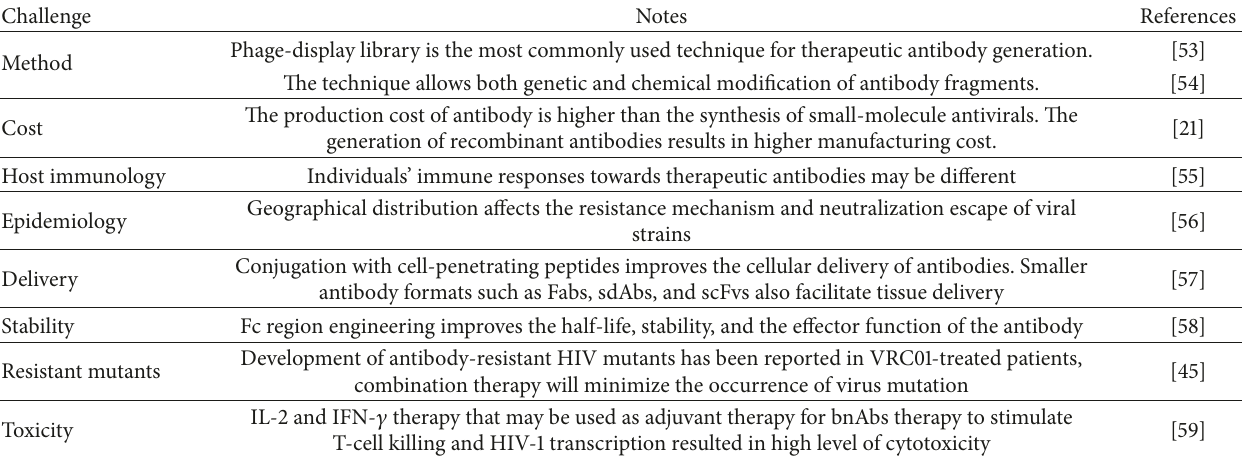
Table 3: Challenges of FDA-approved anti-HIV therapeutic antibodies